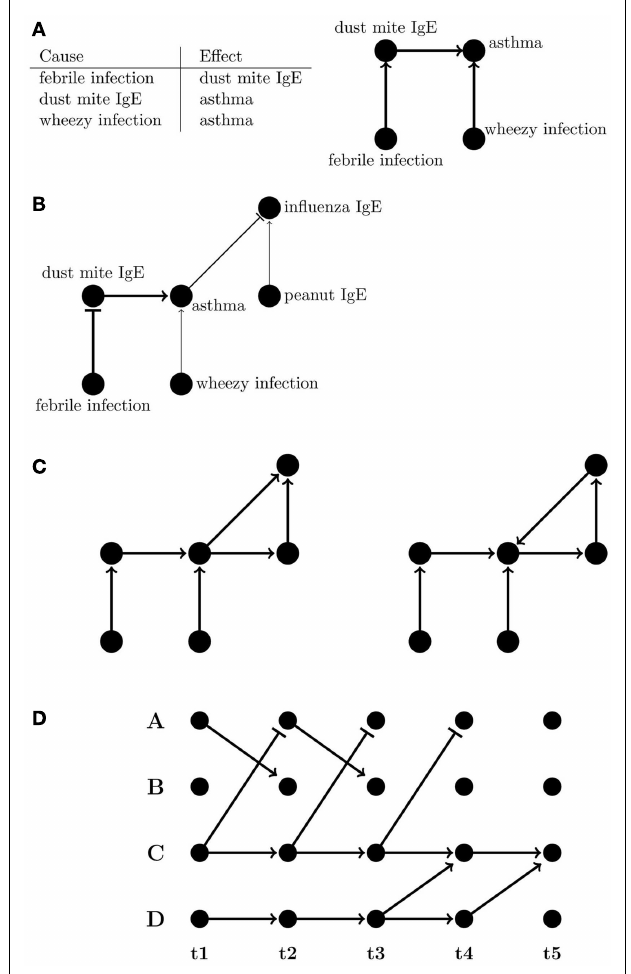
FIGURE 3 | Representations of directed networks . (A) Tabular and graphical (left and right, respectively) displays of directional flow between variables. (B) Graph showing variations in strength and sign of effects between variables.The flattened edges indicate negative relationships. (C) Directed acyclic (DAG) and directed cyclic graphs (left and right, respectively). (D) A dynamic Bayesian network where edges are only between subsequent time